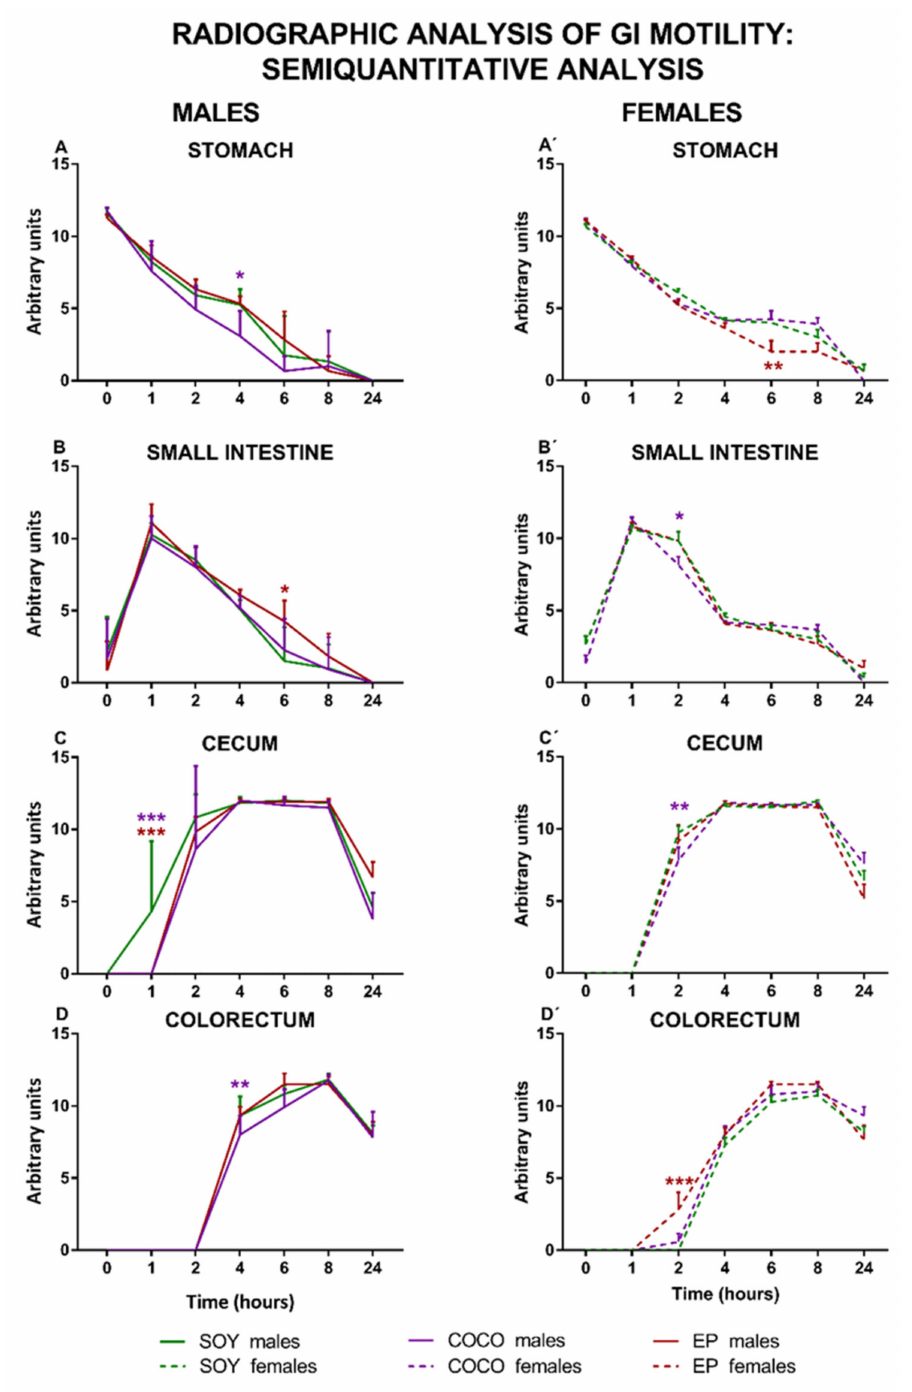
Figure 6. Effects of diet intervention on general gastrointestinal motility (semiquantitative radio- graphic analysis) in the rat. Male ( A – D ) and female ( A’ – D’ ) rats were exposed to AIN-93G diet containing 7% of soybean oil (SOY), or to modified AIN-93G diet containing 3.5% of soybean oil supplemented with 3.5% of coconut oil (COCO) or with 3.5% of evening primrose oil (EP). Figures represent the motility of stomach ( A , A’ ), small intestine ( B , B’ ), cecum ( C , C’ ), and colorectum ( D , D’ ) based on X-rays obtained 0, 1, 2, 4, 6, 8, and 24 h after contrast administration. Data were analyzed in males and females separately. Data are presented as mean ± S.D. ( n = 6–12 animals per group) Two-way ANOVA followed by Bonferroni’s multiple comparison. * p < 0.05, ** p < 0.01, *** p < 0.001 vs. SOY males or SOY